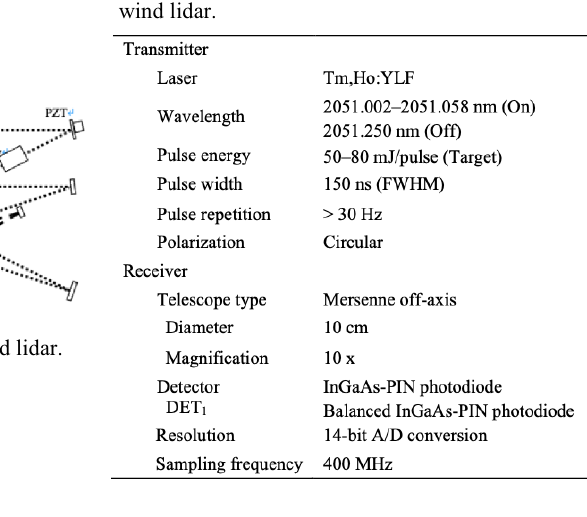
Table 2. Specifications of 2-μm coherent Doppler wind lidar.